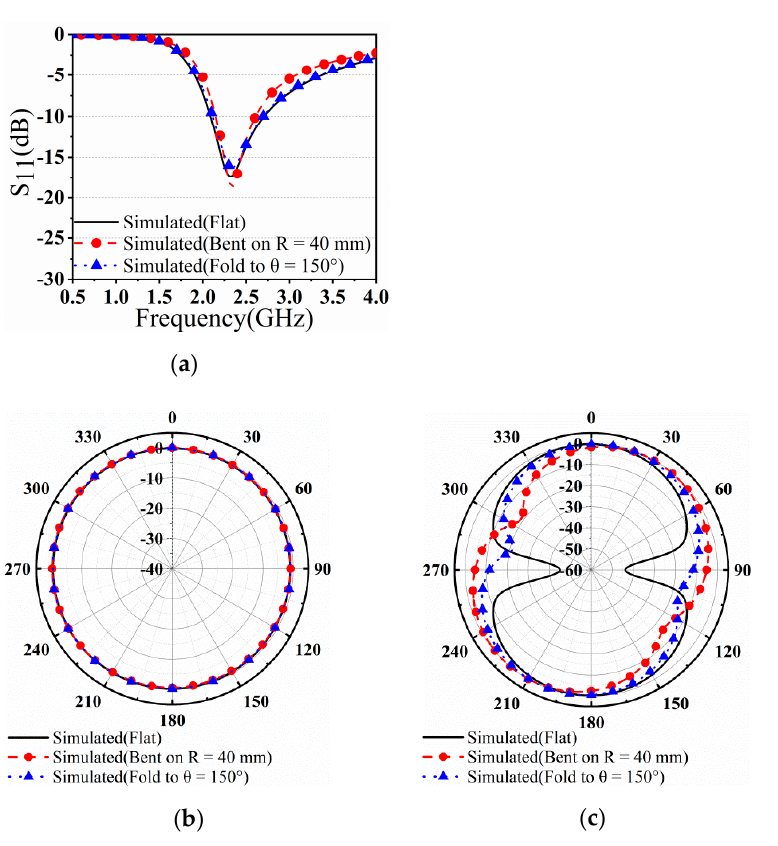
Figure 5. Diagrams of surface current. ( a ) Flat. ( b ) Bent. ( c ) Folded.